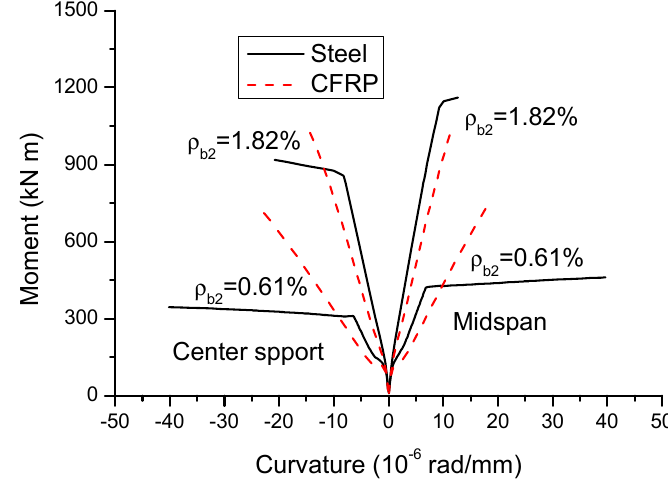
Figure 5. Moment–curvature curves.